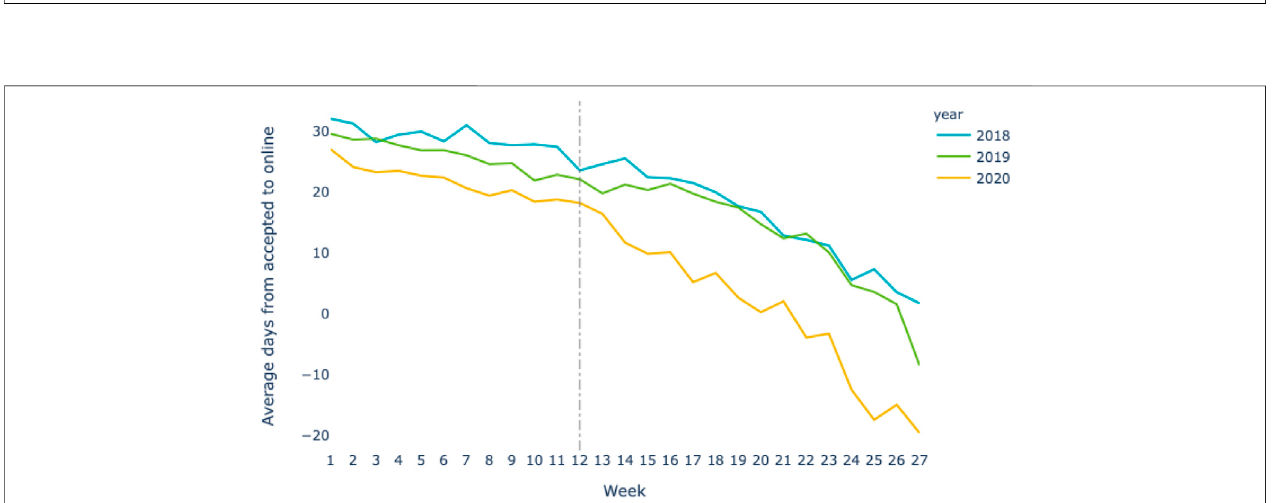
FIGURE 3 | Average days between accepted and online dates. The dotted line indicates week 12, mid-March 2020, where most of the world started entering in someformoflockdown,andschoolswereshutdown.ThevalueforeachweekiscalculatedbytakingallpapersintheDimensionsdatabasethathaveappearedonlinein aspeci fi cweek,calculatingthedifferencebetweenthedateofonlinepublicationandthedateofacceptanceandthentakingtheaverage.Whentheaverageisnegative,it indicates that the largest portion of articles in that week have been published online but not yet fully accepted (i.e. they are accepted with minor revisions).